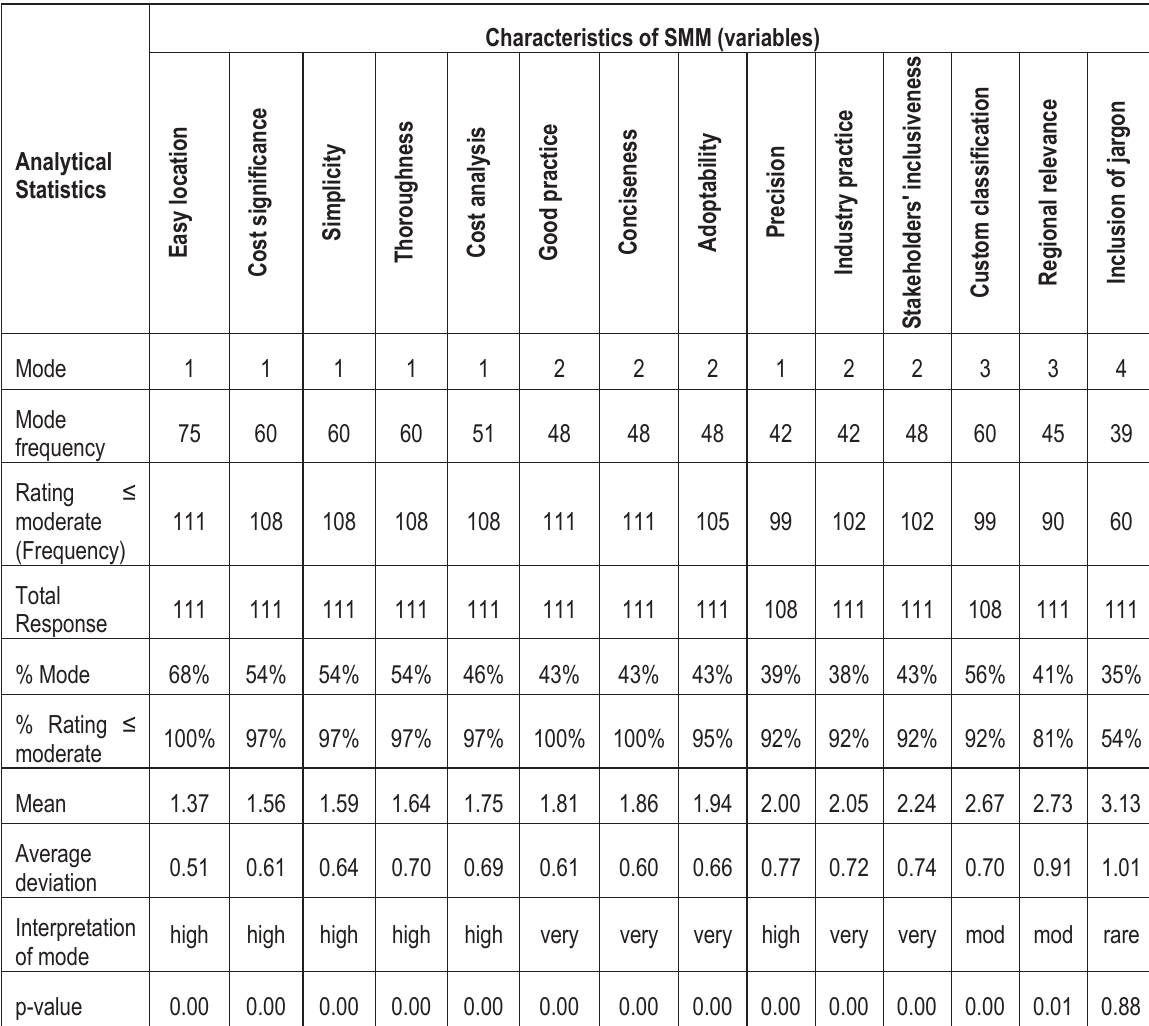
Table 3 Analysis of Survey Response Ratings of Essential properties of an